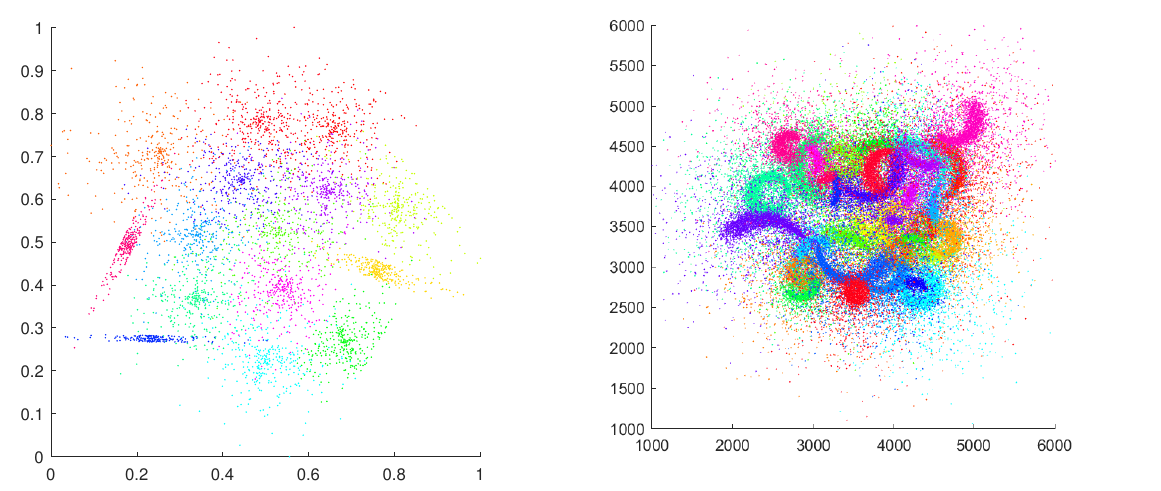
Figure 3. The S4 (left) and Worms_2d (right) datasets. Each color represents a specific